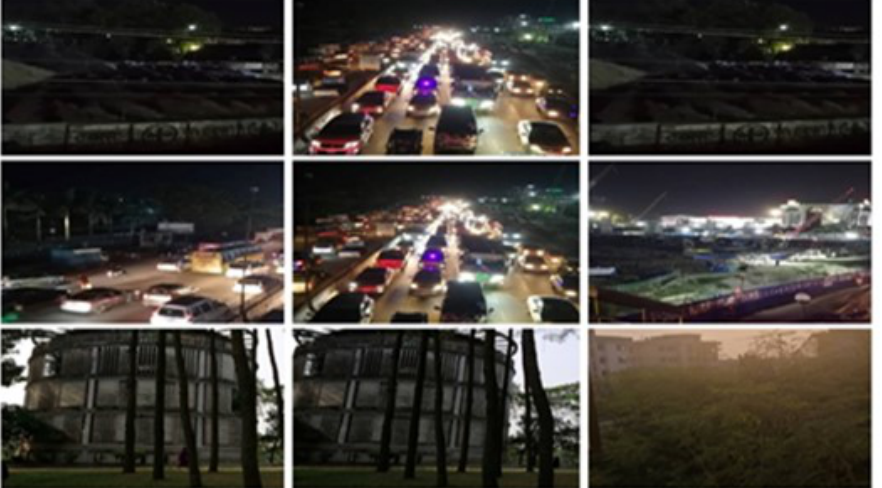
Figure 8. Visual Representation of Customized IELLc